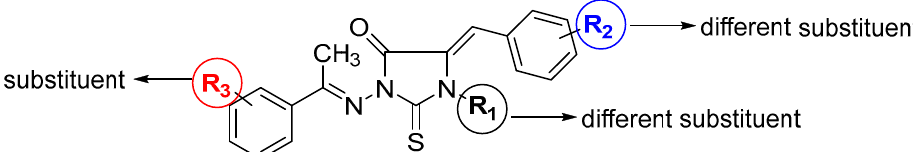
Figure 2. The design and examined structural features of novel 1,3,5-trisubstituted-2-thiohydantoin derivatives.